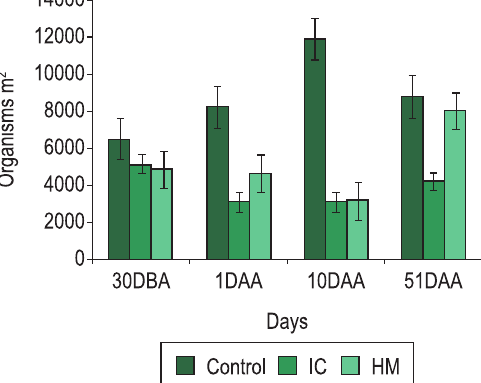
Figure 1. Mean density of organisms found on each sam- pling date. Control: control treatment without pesticide application; IC: Insecticide treatment; HM: Herbicide treatment. Bars represent the standard deviation. (DBA: days before application; DAA: days after application of the